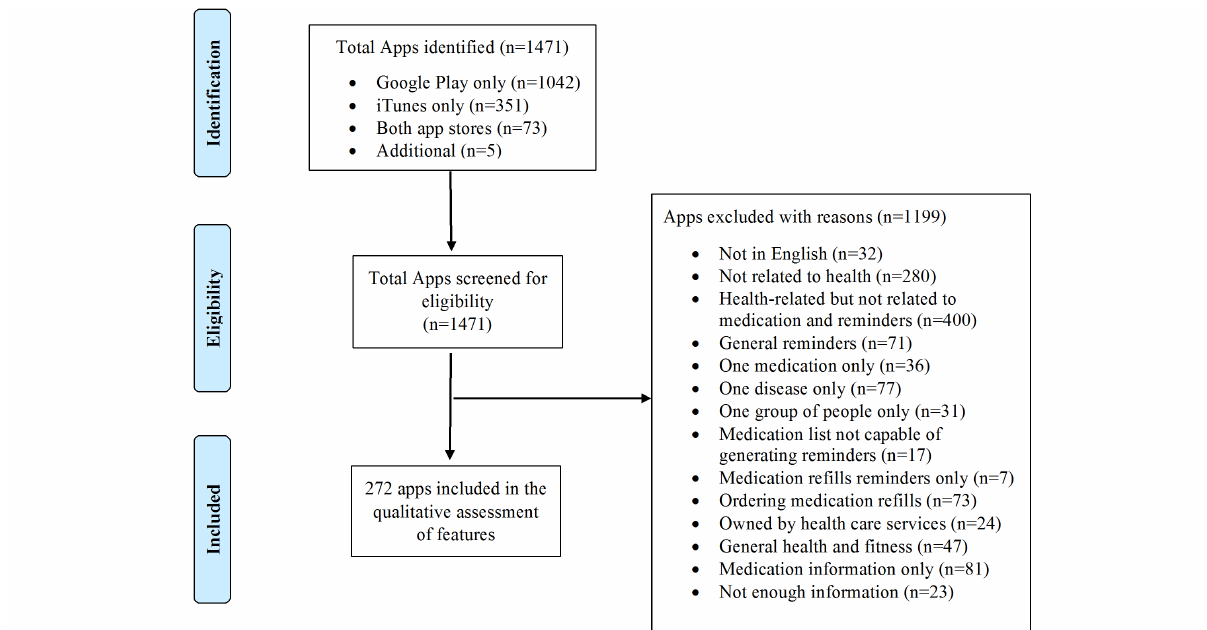
Figure 1. Flowchart of selection of included apps.